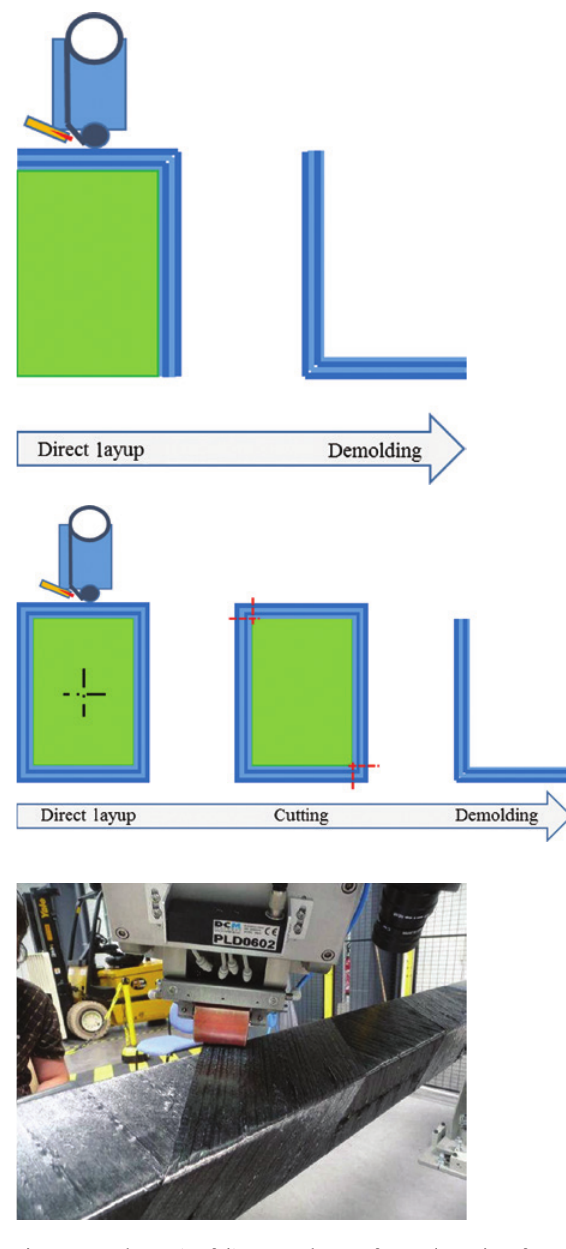
Figure 2: Schematic of direct AFP layup of an L-shaped preform (top) and a square-type bar preform as an initial shape for L- or C-shaped profile preforms (center). Manufacturing close-up of direct AFP preforming (bottom). Source: Airbus Group